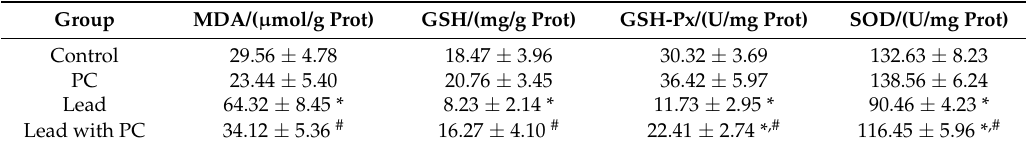
Table 4. The effect of PC on MDA, GSH content, and the activities of GSH-Px and SOD in the liver tissue of mice exposed to lead ( n = 7, X ±